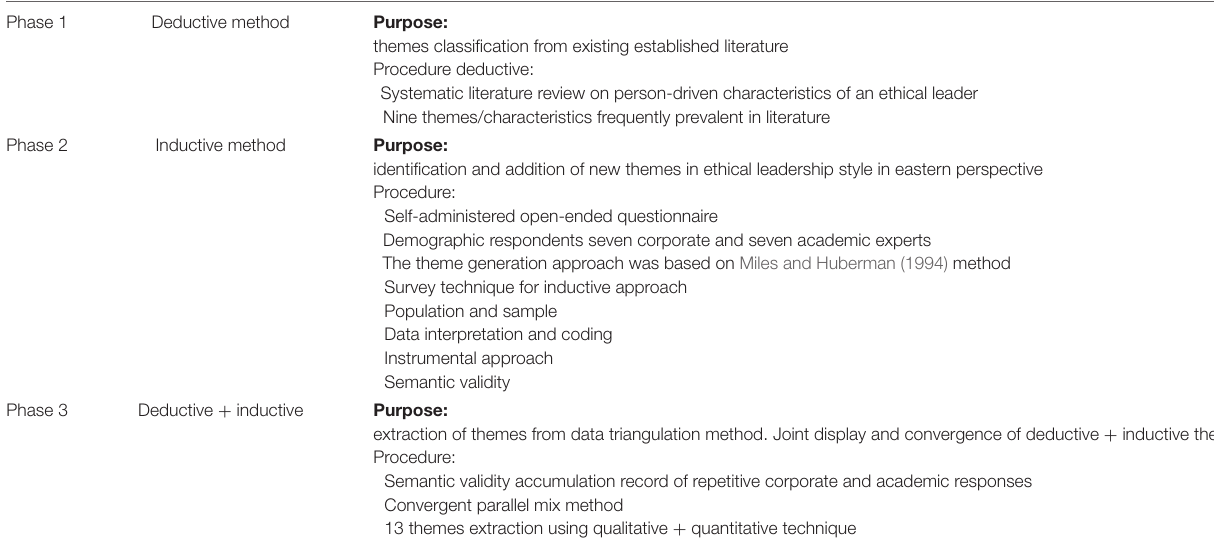
TABLE 1 | Methodological design